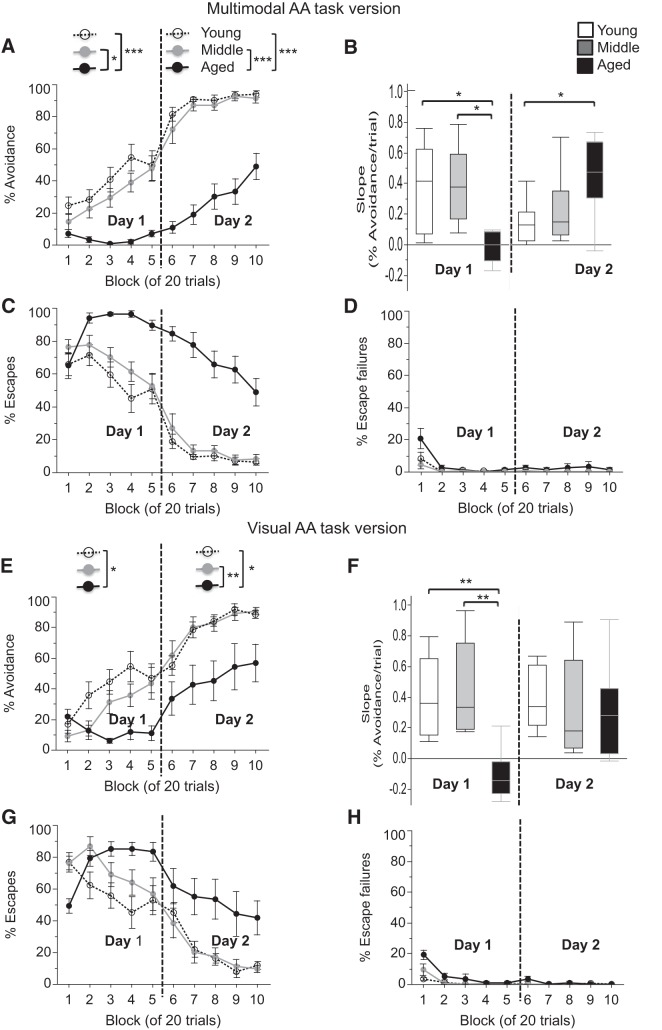
Active avoidance is impaired in aged mice in both multimodal and visual versions of the task. A, E, Percentage of successful avoidance trials is shown in blocks of 20 trials over the 2 day test period for the multimodal (A) and visual (E) version of the task. B, F, Slopes of the percentage of avoidance per trial are shown for the multimodal (B) and visual (F) AA task for both training days. C, D, G, H, The percentages of escapes (C, G) and escape failures (D, H) are shown in blocks of 20 trials over the 2 day test period for the multimodal (C, D) and visual (G, H) AA task. Values are expressed as the mean ± SEM (A, C, D, E, G, H) or box plots, as defined in the Data analysis section in Materials and Methods (B, F). *p < 0.05, **p < 0.005, ***p < 0.0001.